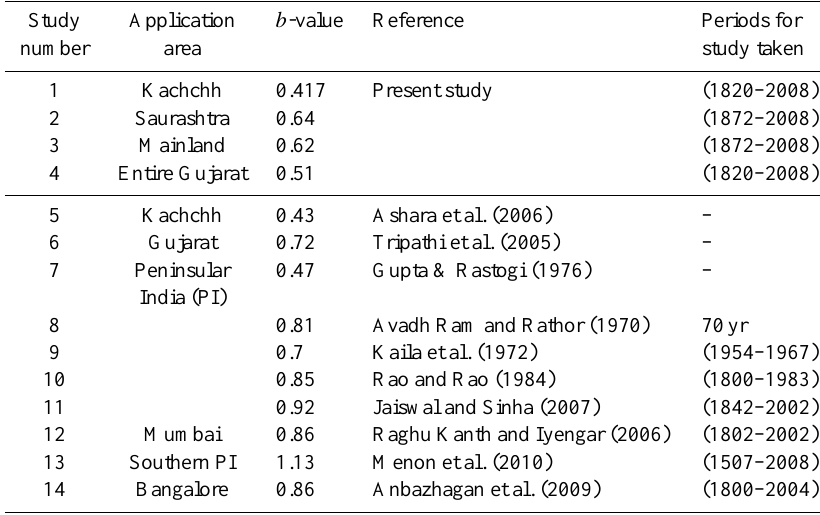
Table 3. Comparison of b -value for the Gujarat region to values reported by various researchers.